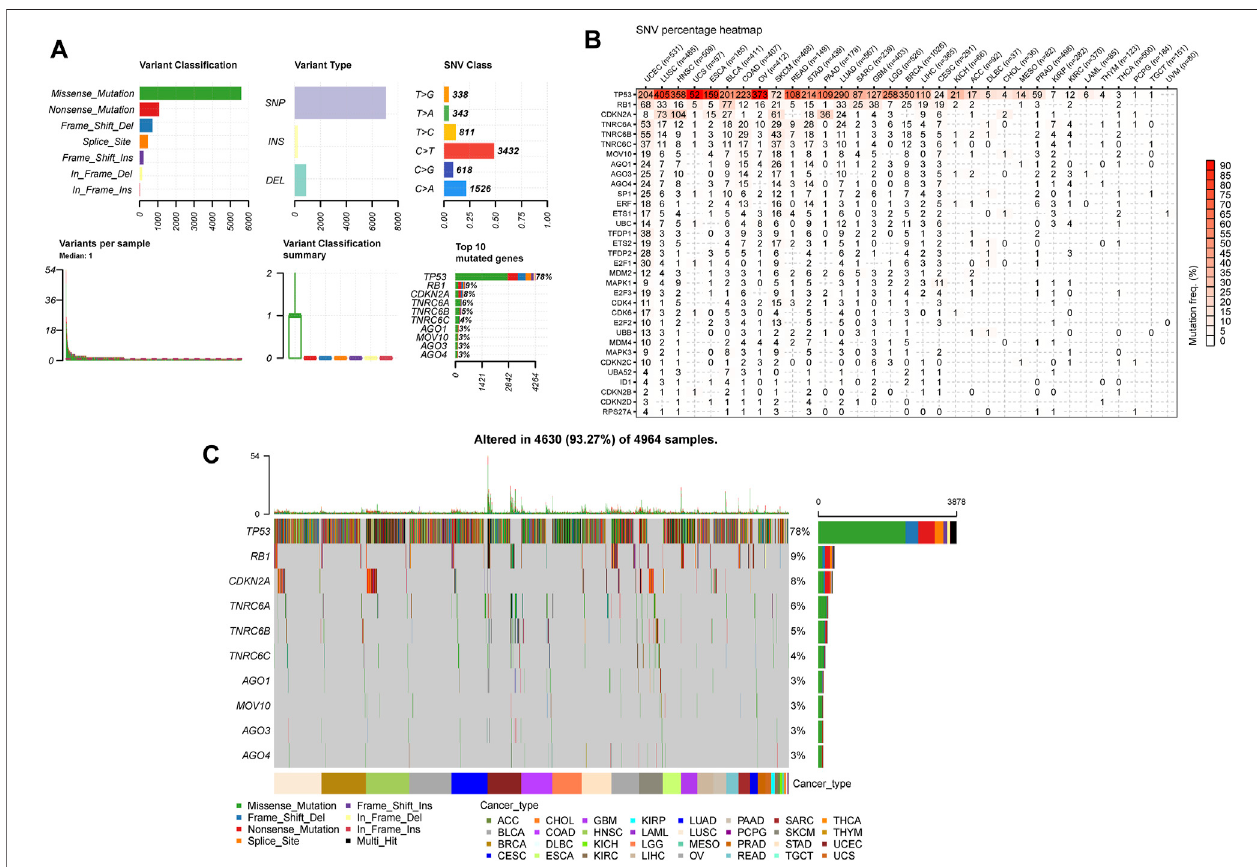
FIGURE 6 | Single nucleotide variation (SNV) analysis in senescence genes. (A) The summaries plot of the SNV variants classi fi cation of SRGs from the TCGA database. Upper left (variant classi fi cation): the count of each deleterious mutation type (Missense_Mutation, Nonsense_Mutation, Frame_Shift_Ins, Frame_Shift_Del, In_Frame_ Del, In_Frame_Ins, and Splice_Site) of SRGs in 33 cancer types. Upper central (Variant Type): the count of single nucleotid polymorphism, INS, and DEL of SRGsin33cancertypes.Upperright(SNVclass):thecountofeachSNVclassofsenescencegenesin33cancertypes.Lowerleft(Variantspersample):thecount of variants in each sample. A bar represents a sample, the color of the bar corresponding to the color of variant classi fi cation. Lower central (variant classi fi cation summary): box plot represents the distribution of the count of each variant classi fi cation in the sample set of 33 cancer types. The color of the box corresponds to the color of variant classi fi cation. Lower right (Top 10 mutated genes): the count and percentage of variants in top 10 mutated genes. (B) Heatmap demonstrating the SNV frequenciesofsenescencegenesacross33cancertypes.Foragivencancer,thenumberofsampleswiththecorrespondingmutationgeneisindicatedbynumbers. (C) Oncoplot depicting the mutation distribution and the classi fi cation of SNV types of top 10 mutated genes from senescence genes in 33 cancer types.